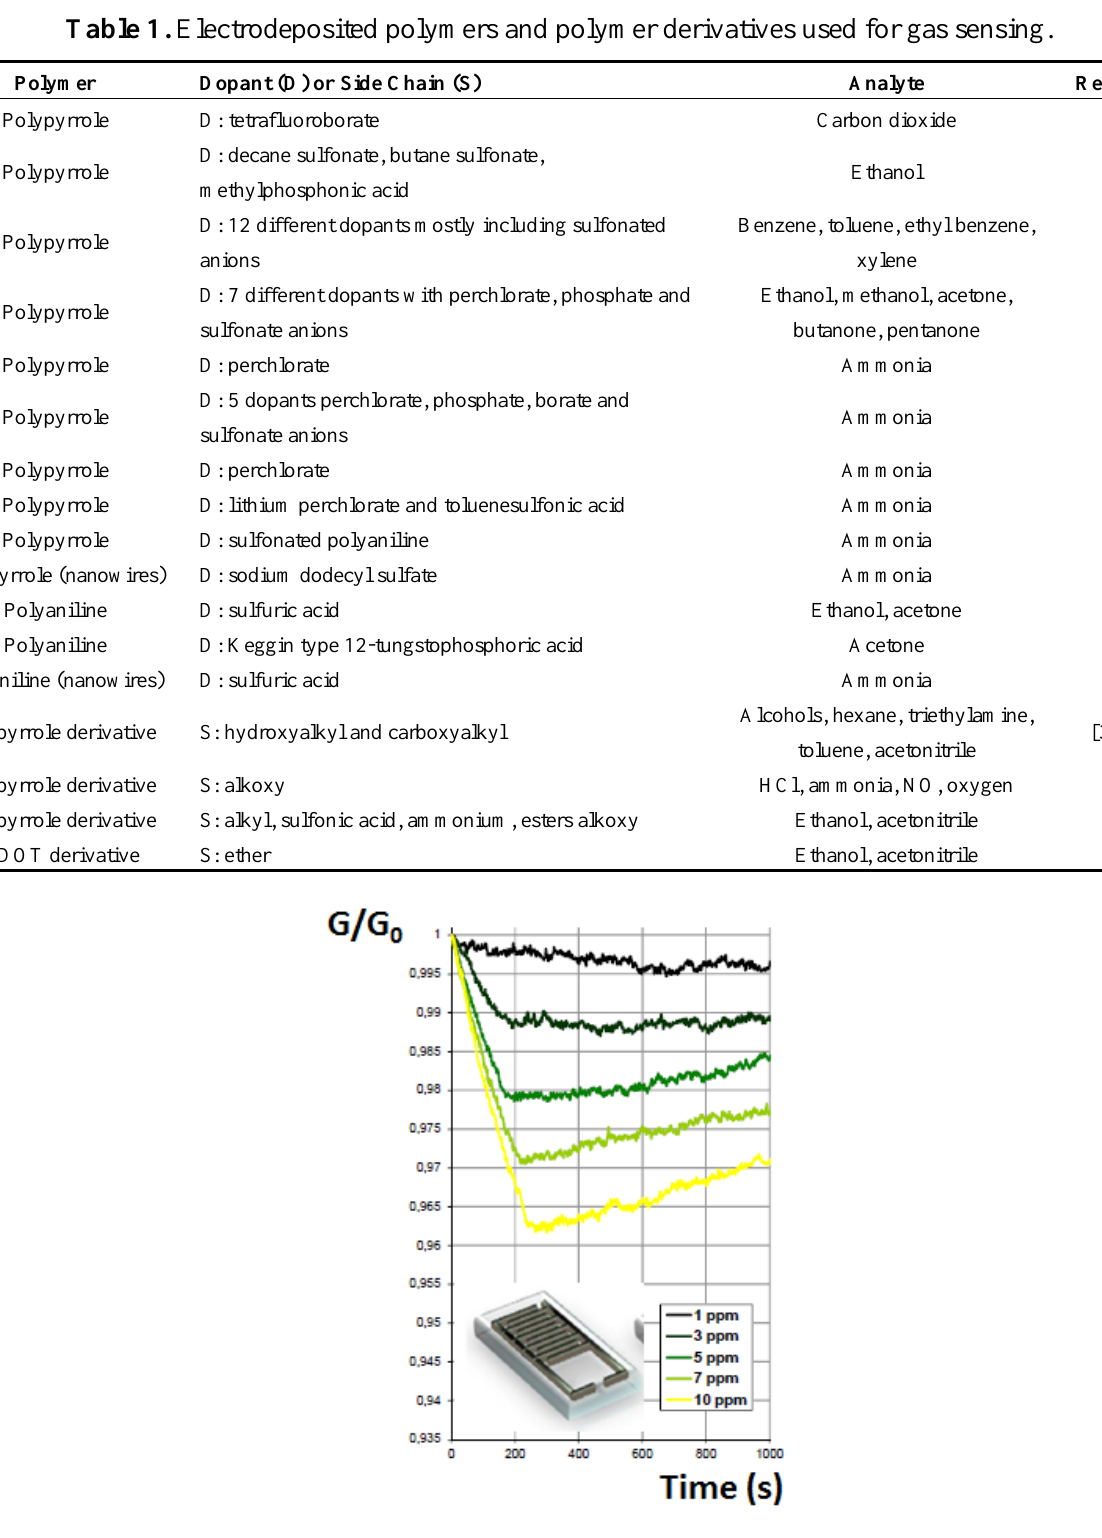
Figure 2. Conductimetric response to ammonia changes of a polypyrrole film deposited at +1 V/SCE from an aqueous electrolyte containing 0.1 M LiClO 4